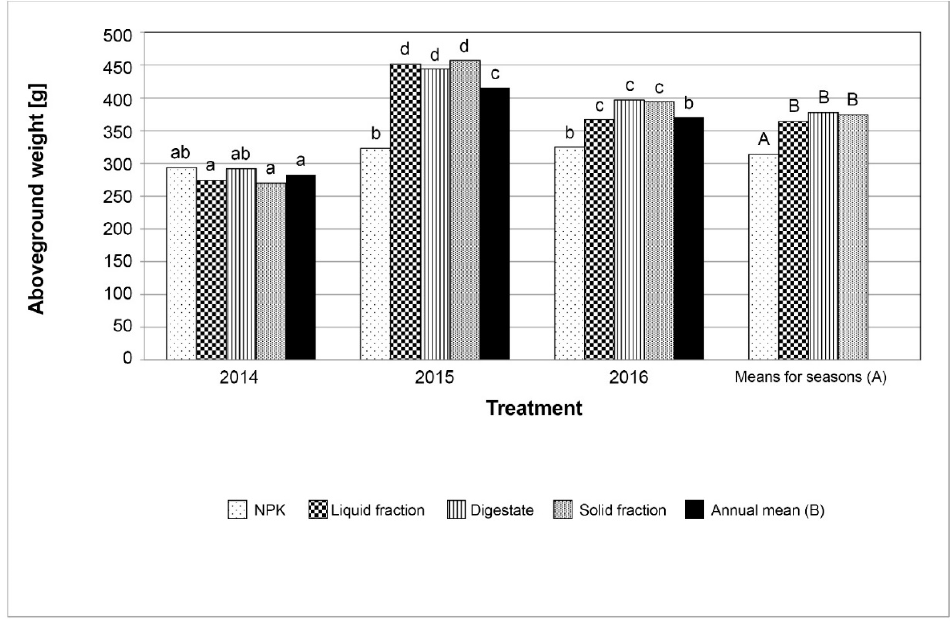
Figure 6. Weight of maize above-ground biomass in respective growing seasons and experimental treatments. Legend as at Figure 4.